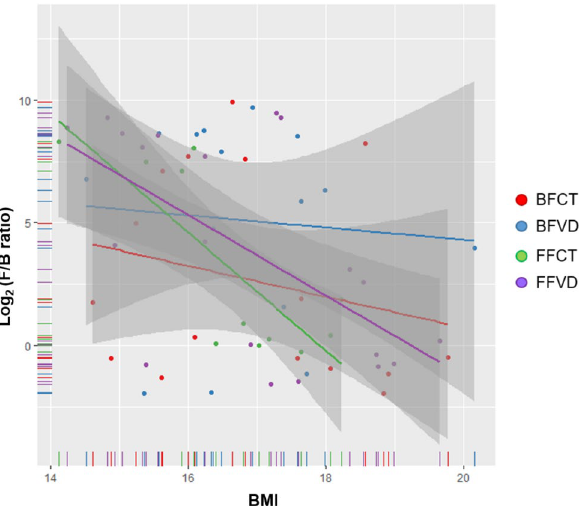
Figure 10. Linear regression results between BMI and F/B ratio at 4-month-old of age in 4 groups of